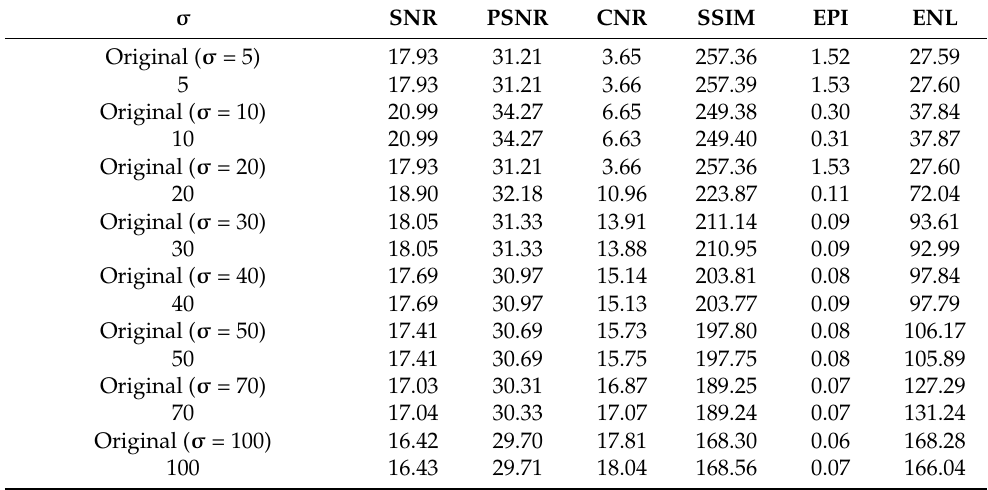
Table 1. Quantitative evaluations of the proposed method with the different noise standard devia- tions ( σ ).